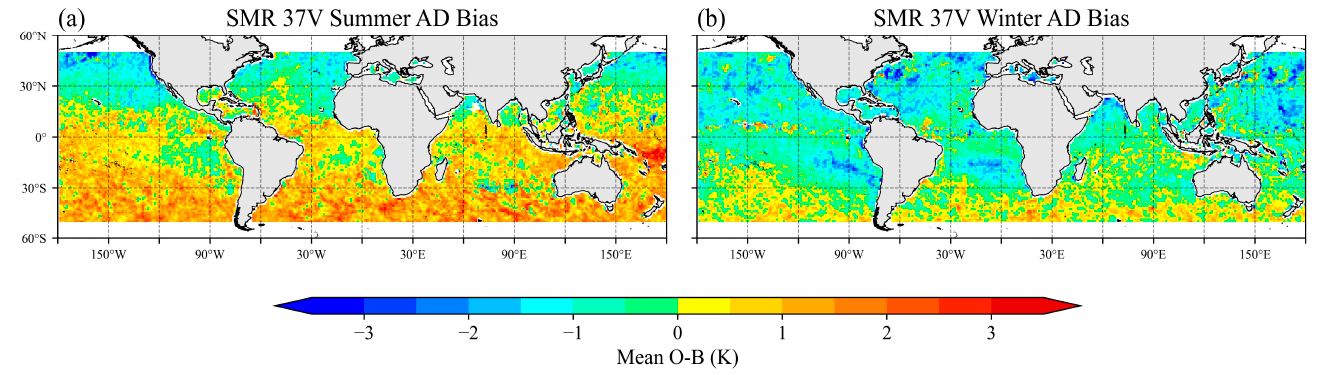
Figure 13. Spatial distribution of AD bias, shown for ( a ) SMR 37 V summer statistics (from 10 July 2021 to 10 August 2021), ( b ) SMR 37 V winter statistics (from 10 January 2021 to 10 February 2021). The simulation is based on ERA5, and all statistics are given after applying the QC procedures described in Section 2.4.